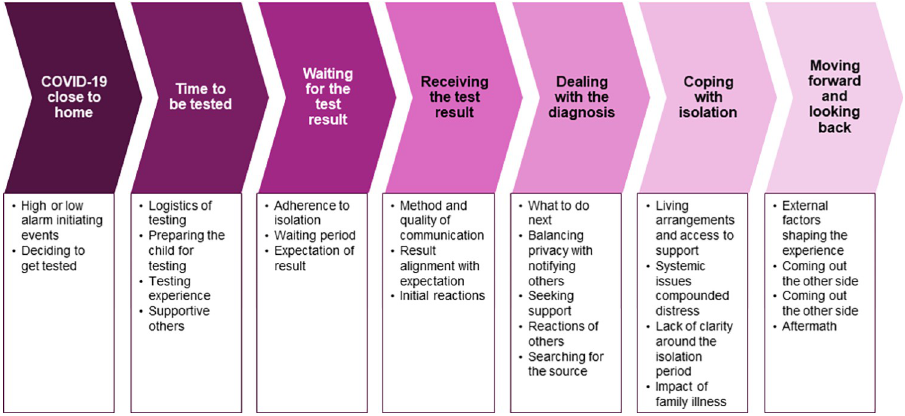
Fig 1. The COVID-positive child journey framework–key timepoints in families’ lived